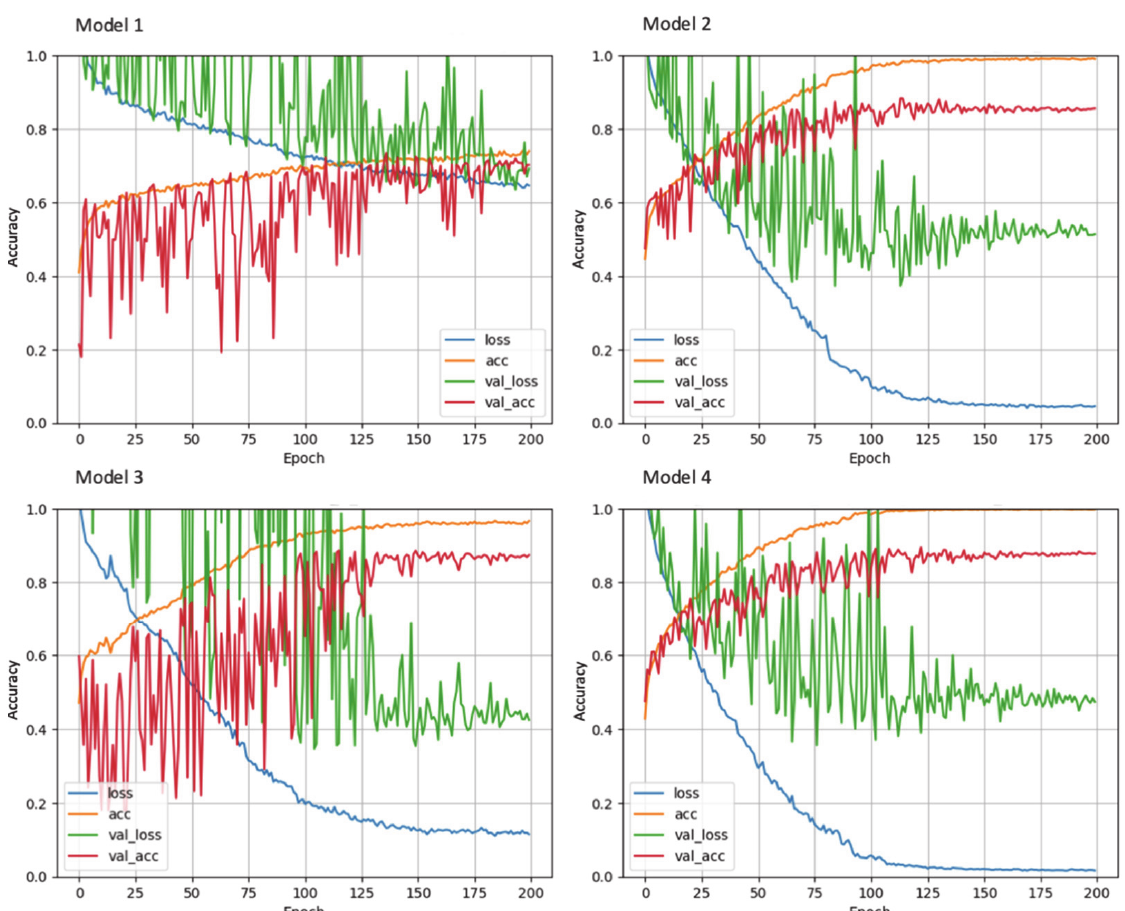
Figure 5. Learning curves of the different dCNN models (1–4) on the training and validation dataset. Accuracy is shown on the y-axis versus number of epochs on the x-axis. Model 1: SGD optimizer; model 2: ADAM optimizer; model 3: increased data augmentation; model 4: halved input size. The best performance was achieved by model 3. Table 2 . Confusion matrices of the different dCNN models (1–4) on the test dataset, with 1: “healthy tissue”, 2/3: “probably benign opacities”, 3/4: “suspicious opacities”. The correctly assigned classes are highlighted in bold.